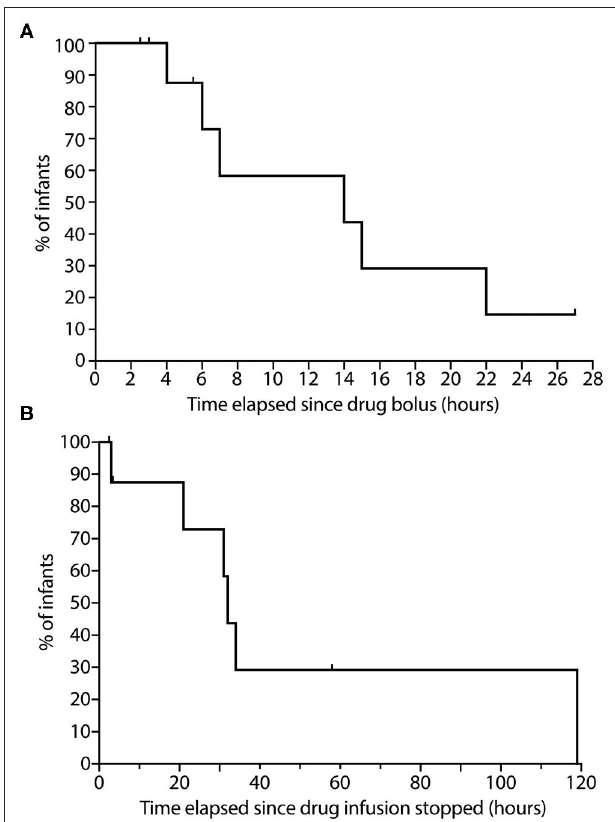
FIGURE 5 | Time course to neuromuscular blockade recovery in infants following. (A) Rocuronium bolus dosing; and (B) Continuous vecuronium infusion. (A) The percentage of infants following rocuronium bolus dosing with TOF ratio < 70% is displayed on the graph ( n = 10). Data were collected up to 27h of recovery from neuromuscular block. (B) The percentage of infants following cessation of continuous vecuronium infusion with TOF ratio < 70% is displayed on the graph ( n = 9). Data were collected up to 119h of recovery from neuromuscular block. Ticks represent tested infants whose TOF ratio remained < 70%. TOF,